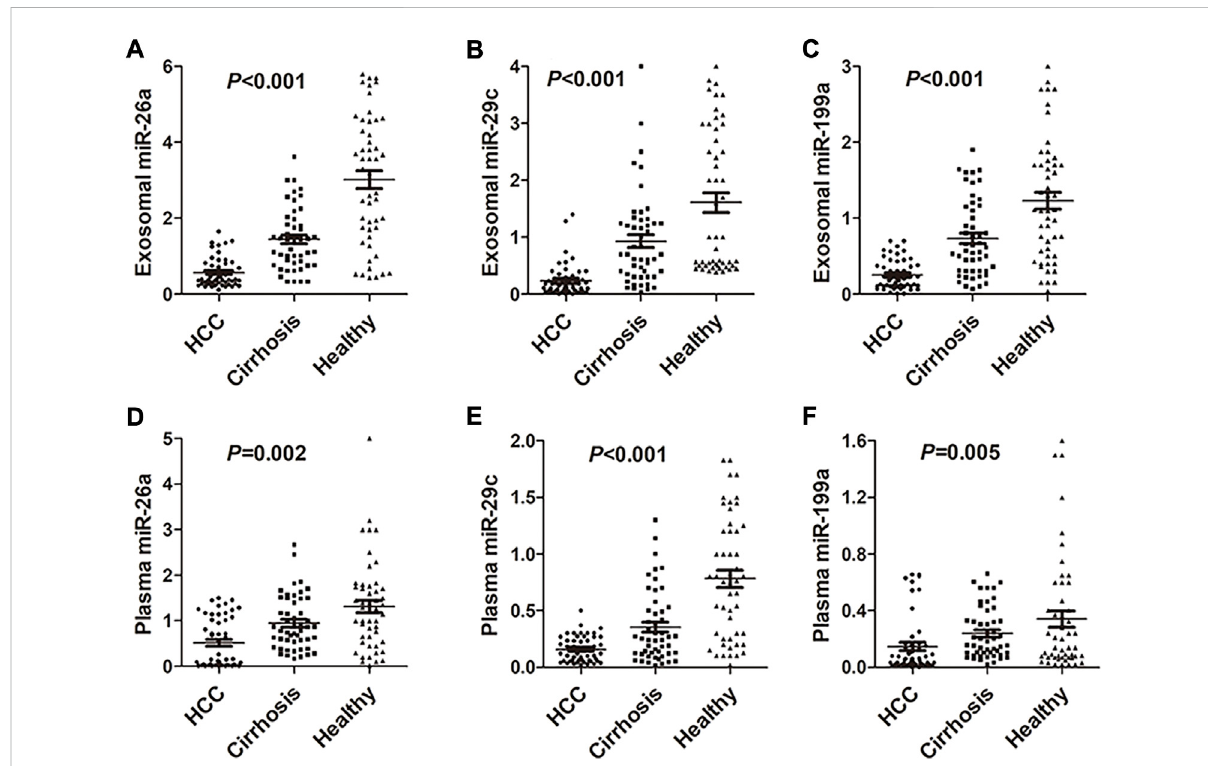
FIGURE 2 Expression of miRNA-26a, miRNA-29c, and miRNA-199a in HCC, hepatic cirrhosis, and healthy group. (A – C) Expression of miRNA-26a (A) , miRNA-29c (B) ,andmiRNA-199a (C) inexosomesofHCC,hepaticcirrhosis, andhealthygroup. (D – F) ExpressionofmiRNA-26a (D) ,miRNA-29c (E) , andmiRNA-199a (F) inplasmaofHCC,hepaticcirrhosis,andhealthygroup.One-wayanalysiswasperformedamongHCC,hepaticcirrhosis,andthe healthy group. HCC, hepatocellular